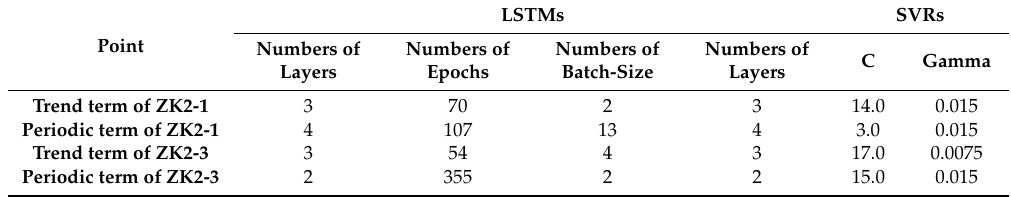
Table 3. Optimal hyperparameters of LSTMs and support vector regressions (SVRs) used for the dataset.